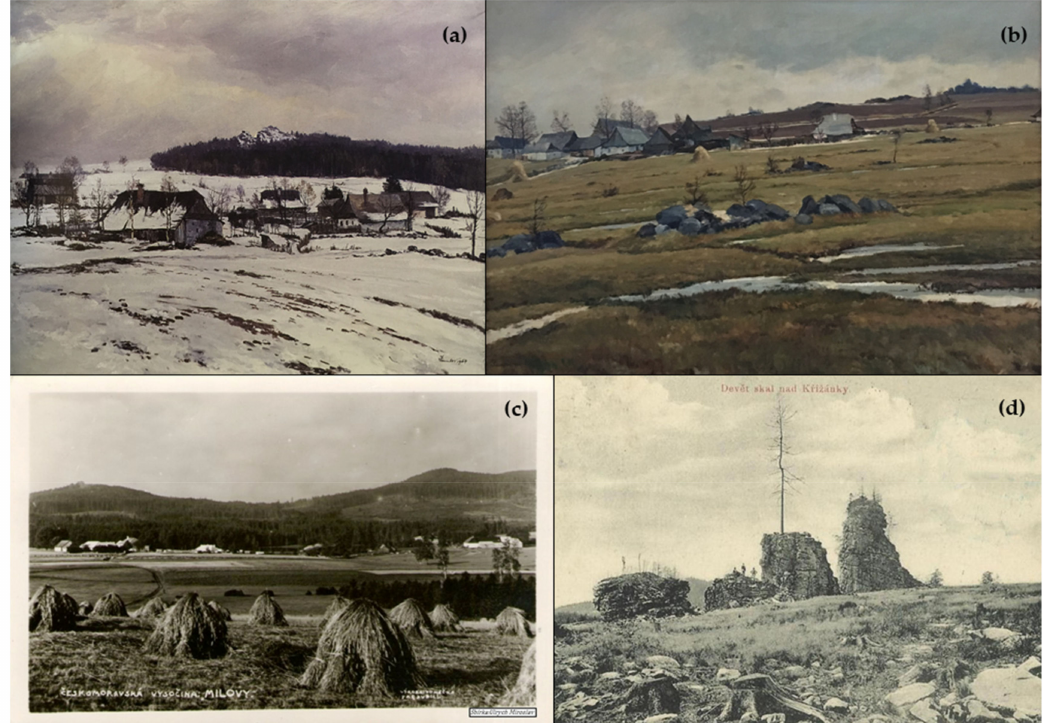
Figure 4. Dr á tenick á sk á la in the landscape paintings of local artists and in historical photographs Blatiny, Josef Jambor, 1946; ( c ) Milovy with Dr á tenick á and Mal í nsk á sk á la in background, 1941 [69]; and ( d ) uncovered outcrops of Devˇet skal after windbreak in 1930